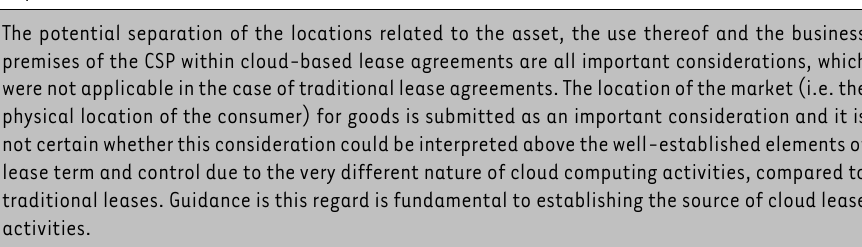
TABLE 1: Issues identified relating to source determination of lease income Importance of location of market for lease